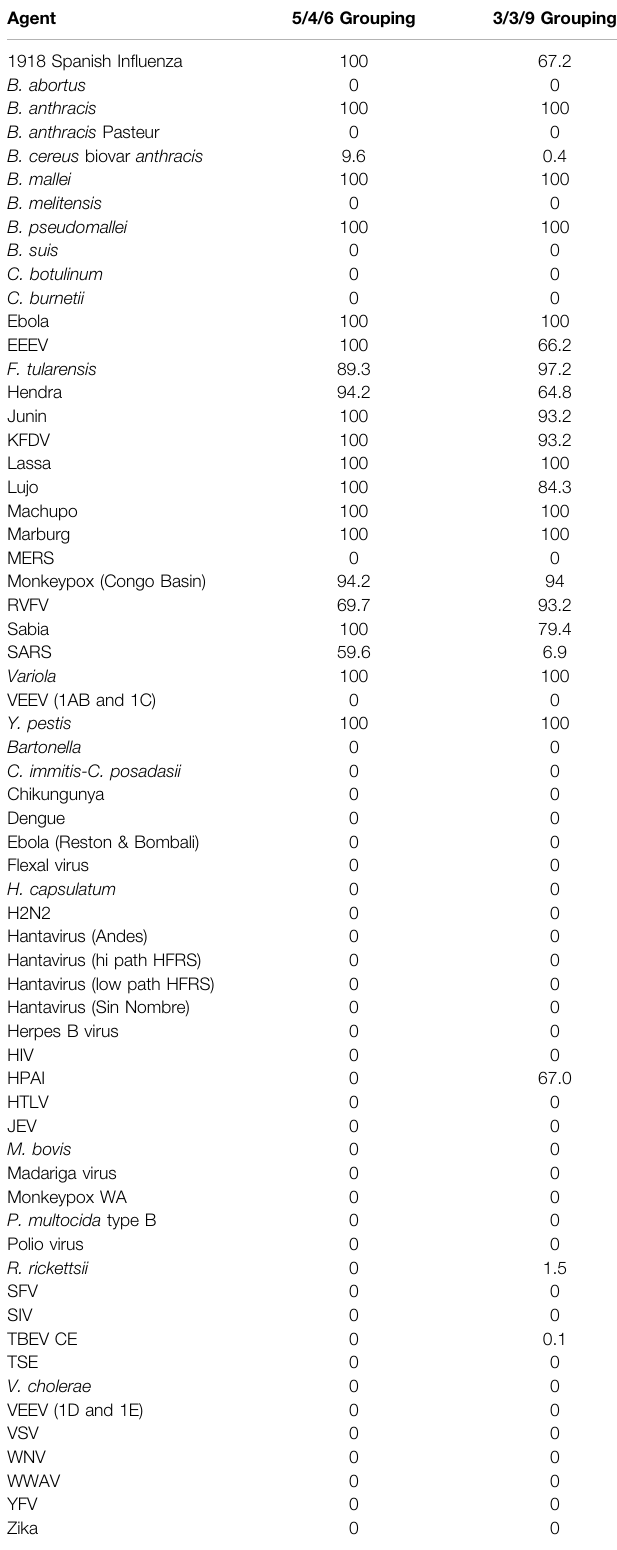
TABLE 5 | Percentage of scenarios in the sensitivity analysis where the agent scorewaswithintheselectagentregionasde fi nedbythresholdsx ≥ 0.36and y ≥